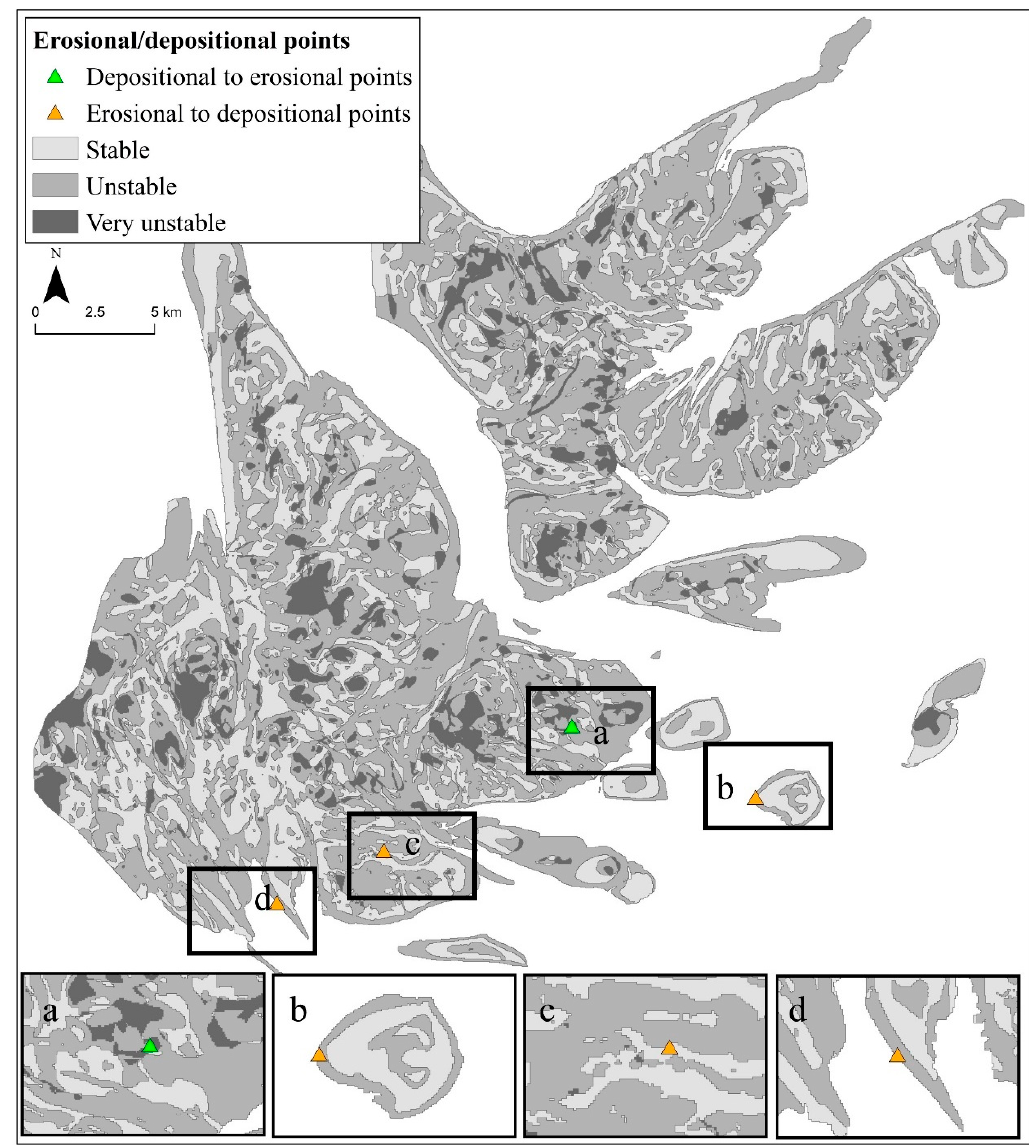
Figure 7. Distribution of erosional/depositional points (the differently coloured triangles represent erosional/depositional points) (( a – d ) are the specific locations of the points).